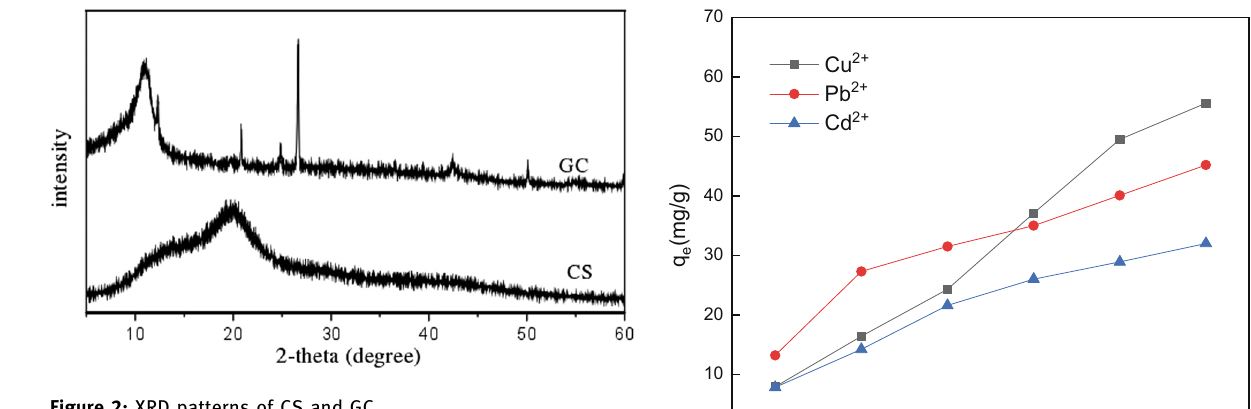
Figure 2: XRD patterns of CS and GC.